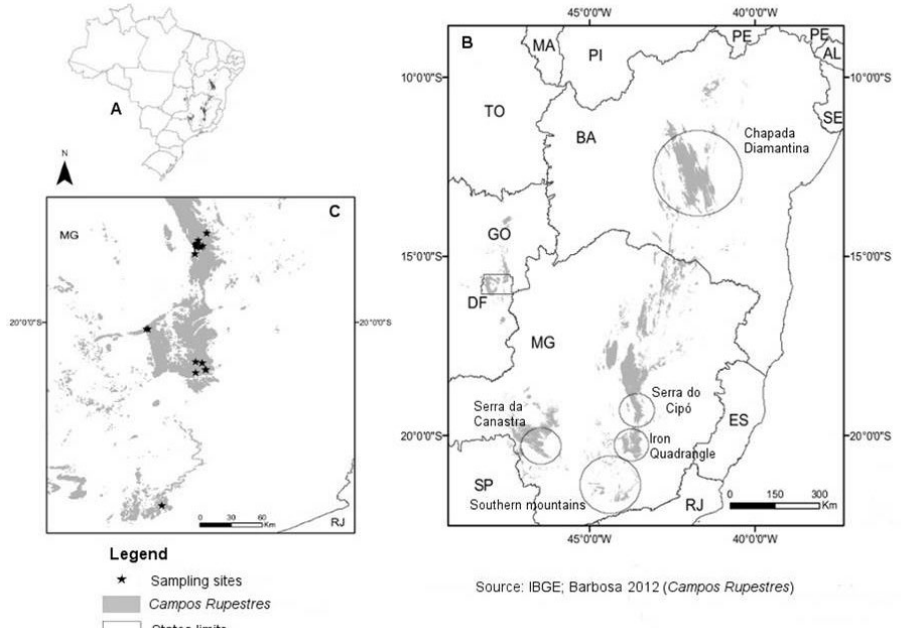
Fig 1 . The location of rocky grasslands in Brazil (A). Rocky grasslands along the Espinhaço Mountains and other Brazilian mountain ranges (circum- scribed) (B). Sampling sites in the southern part of the Espinhaço Mountains and the southern mountains of Minas Gerais